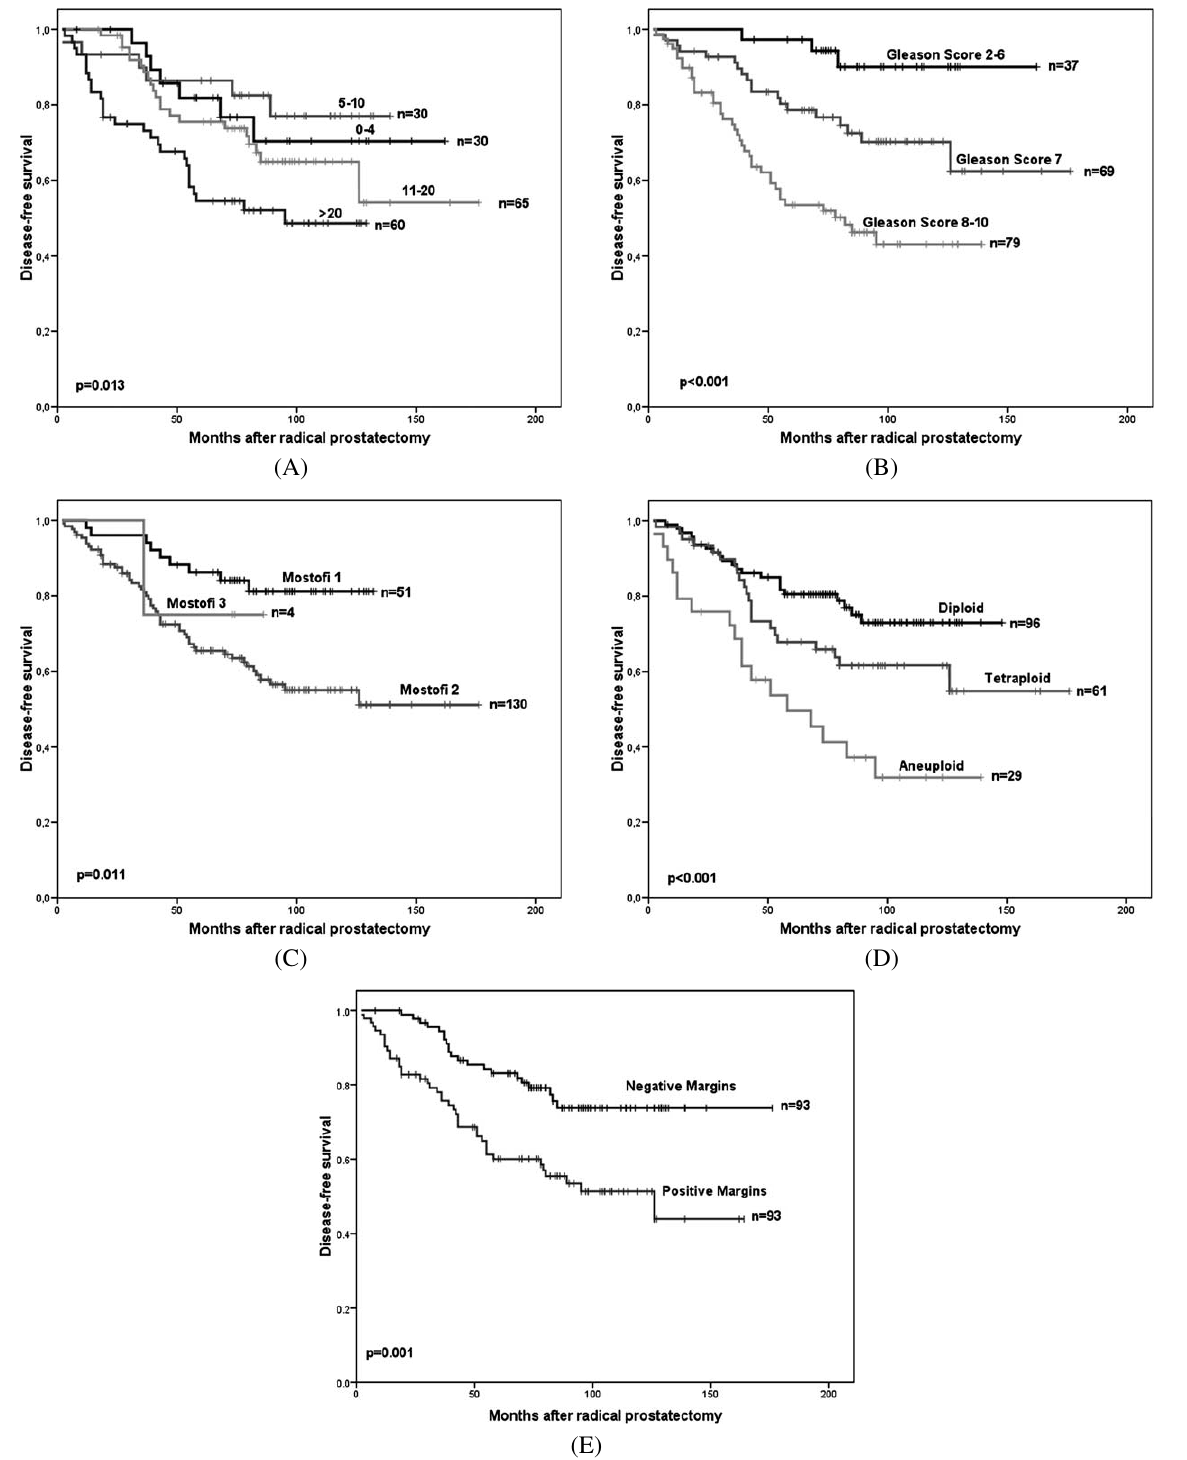
Fig. 1. Disease-free survival shown by Kaplan–Meier graphical analysis for all patients according to (A) preoperative PSA (ng/ml), (B) Gleason score, (C) Mostofi grade, (D) DNA ploidy and (E) surgical